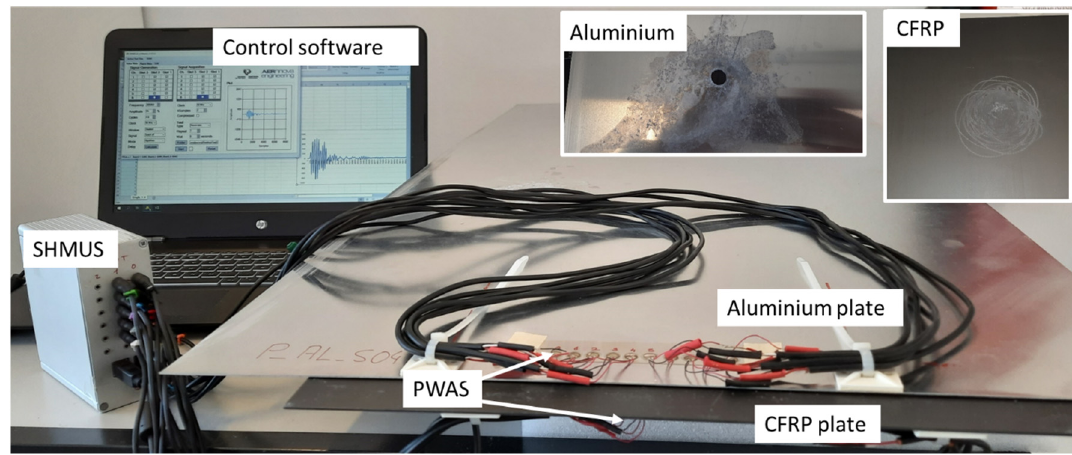
Figure 2. Complete setup for the tests on aluminum and CFRP specimens.